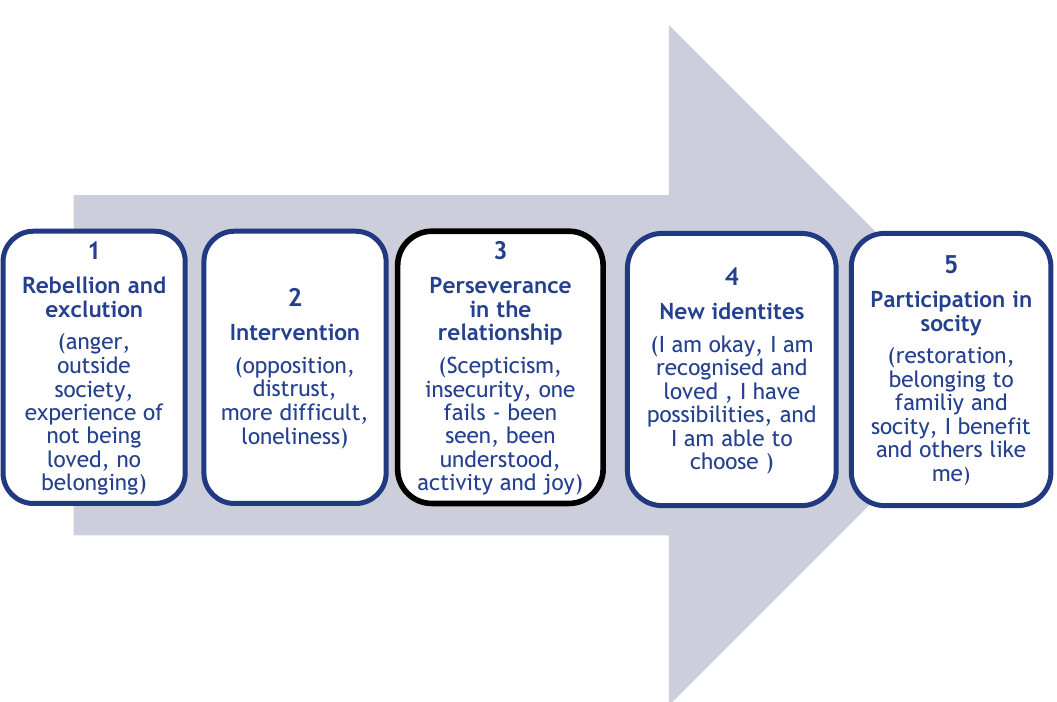
Figure 1. The youths’ development and the significance of love in practice. The five phases show the steps from of the progress in the young people’s life. The text in the parenthesis shows the youth experience in the different phases. Phase 3 is framed as a turning